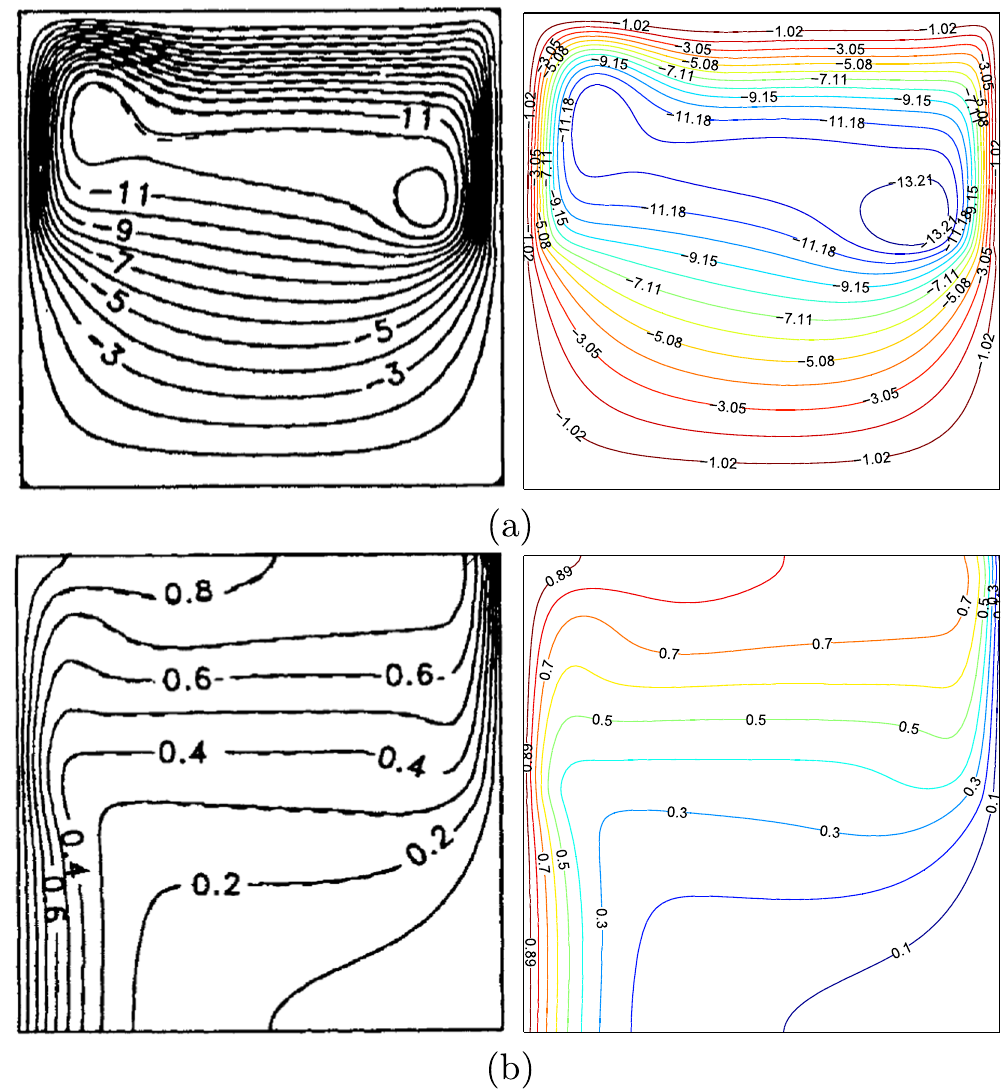
Figure 2. Streamlines ( a ), Singh and Thorpe 7 (left), present study (right), isotherms ( b ), Singh and Thorpe 7 (left), present study (right) for Ra = 10 6 , Da = 10 − 5 , φ = 0, S = 0.5, ϕ = 0 and Pr =